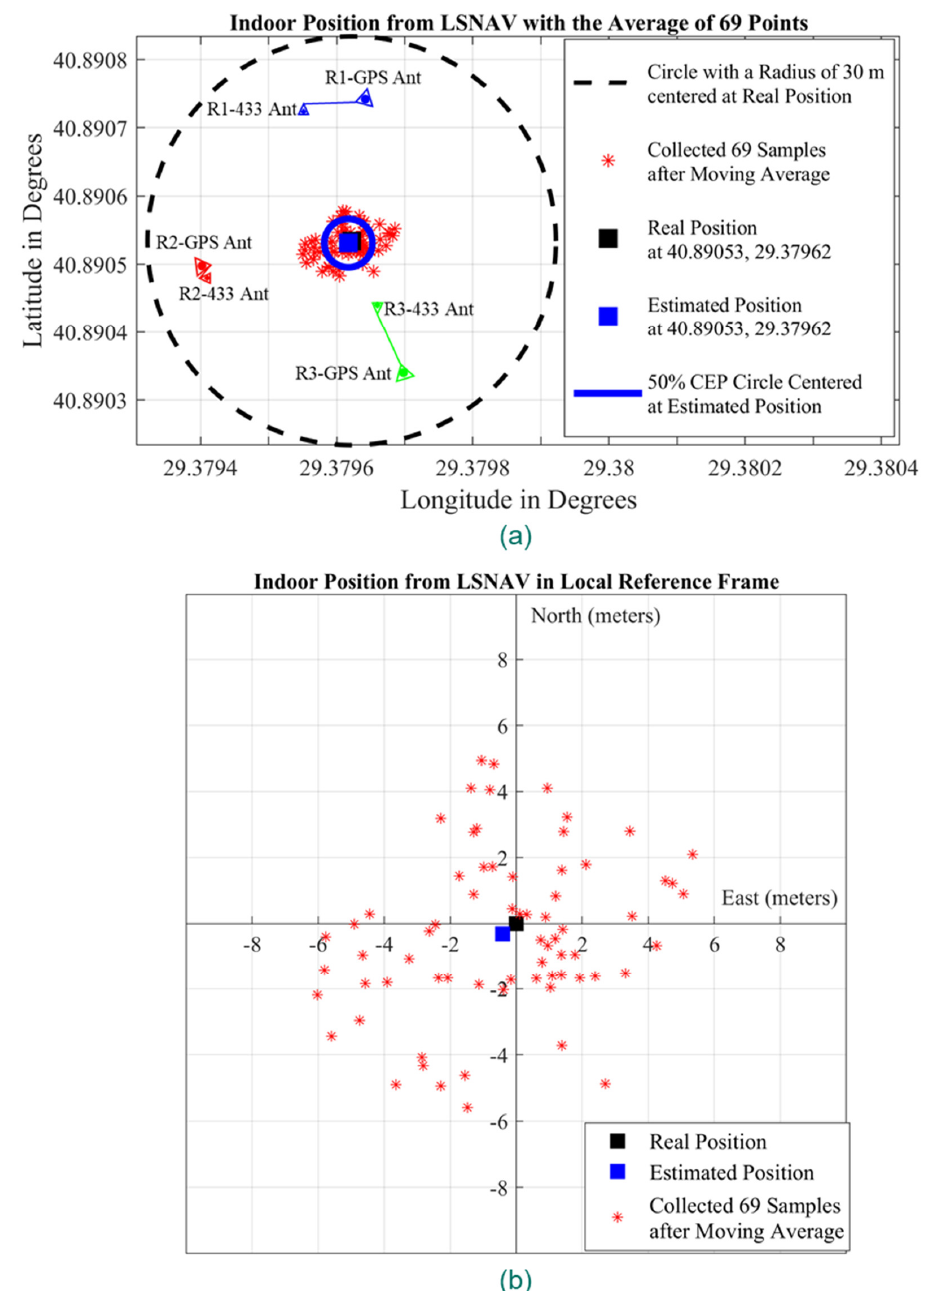
Figure 15. The results of the Experiment 1: ( a ) repeater positions, outdoor GPS antenna positions, collected samples (red dots), real position of the receiver (black square), estimated position (blue square), and CEP (blue circle) on latitude– longitude graph; ( b ) collected samples (red dots), real position of the receiver (black square), estimated position (blue square) on local reference frame whose center is the real position of the receiver.